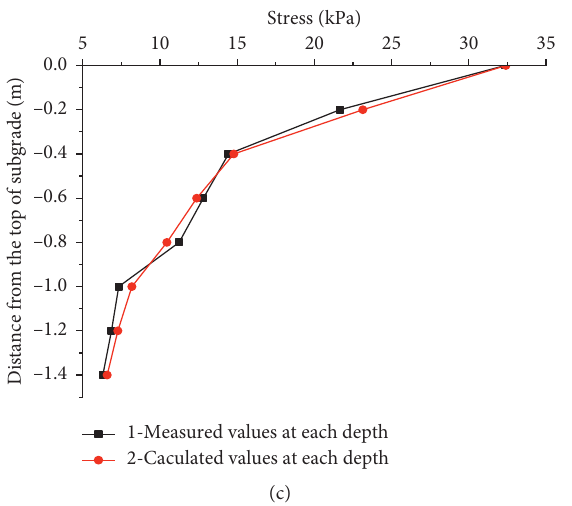
Figure 8: Comparison between the calculated and measured values of dynamic stress at each depth of 50000 loading cycles. (a) The moisture content of the foundation was 18%. (b) The moisture content of the foundation was 23%. (c) The moisture content of the foundation was